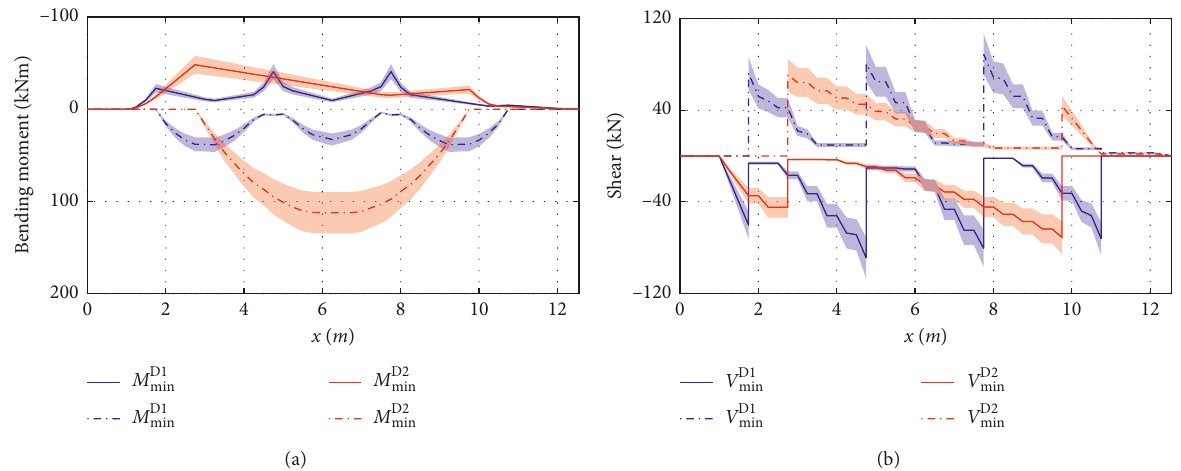
Figure 9: Envelopes of the bending moment and shear force in the deck for the two design alternatives (D1 and